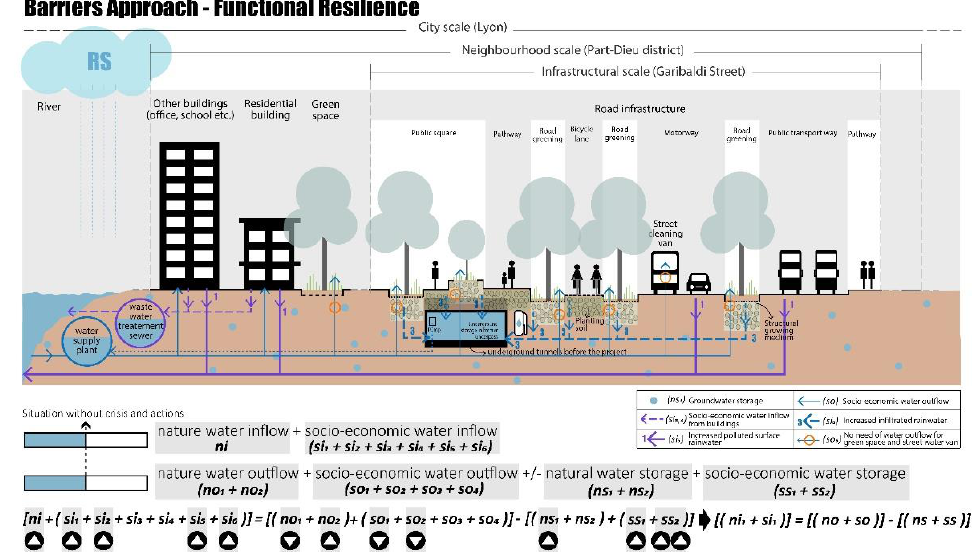
Figure 9. Inside the “barrier”, functional resilience rainy scenario, realised by authors, adapted from TDAG [101].